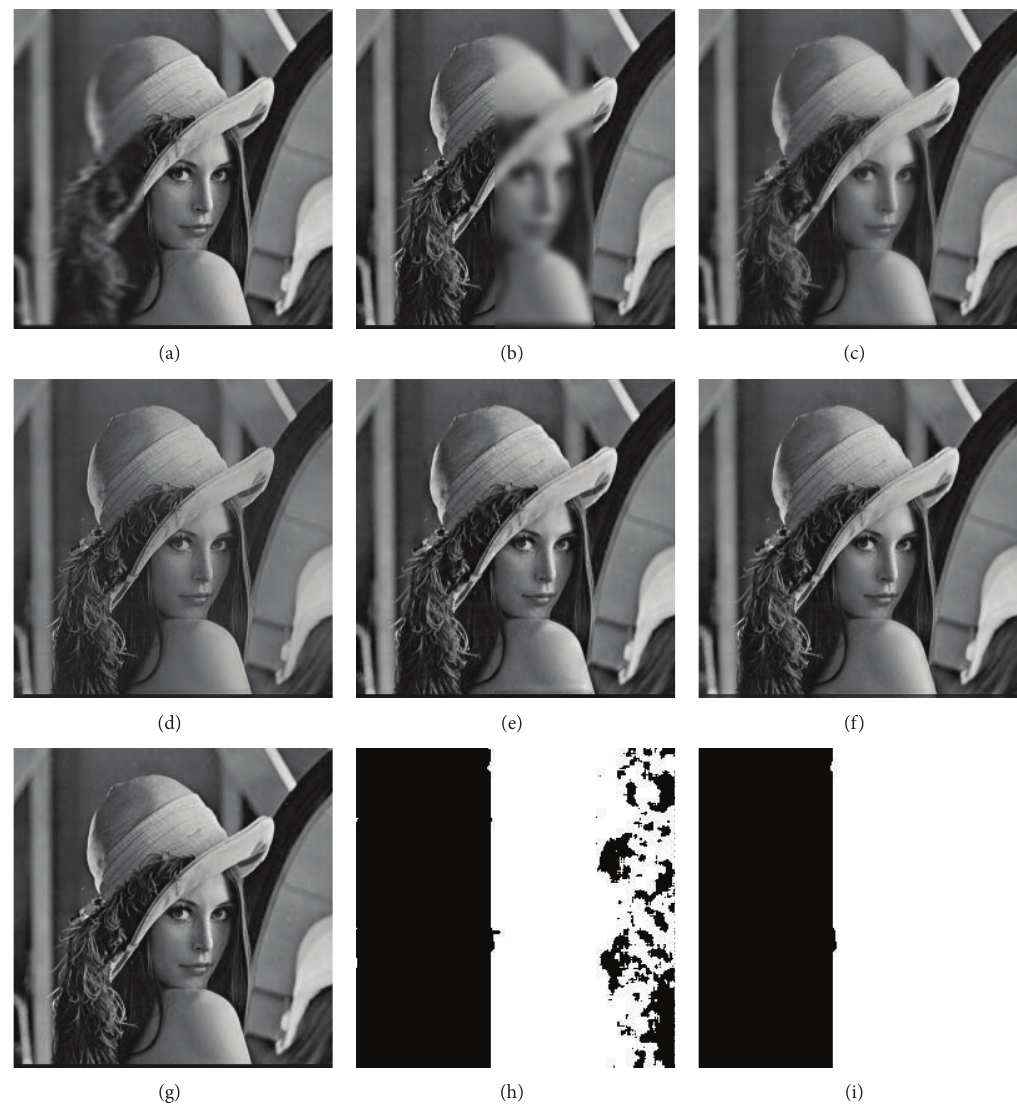
Figure 4: Original images and fused images of “lena”: (a) focus on the right; (b) focus on left and right sides; (c) fused image using average; (d) fused image using gradient pyramid; (e) fused image using DWT; (f) fused image using SIDWT; (g) fused image using the proposed method; (h) the initial focused region; (i) the modified focused